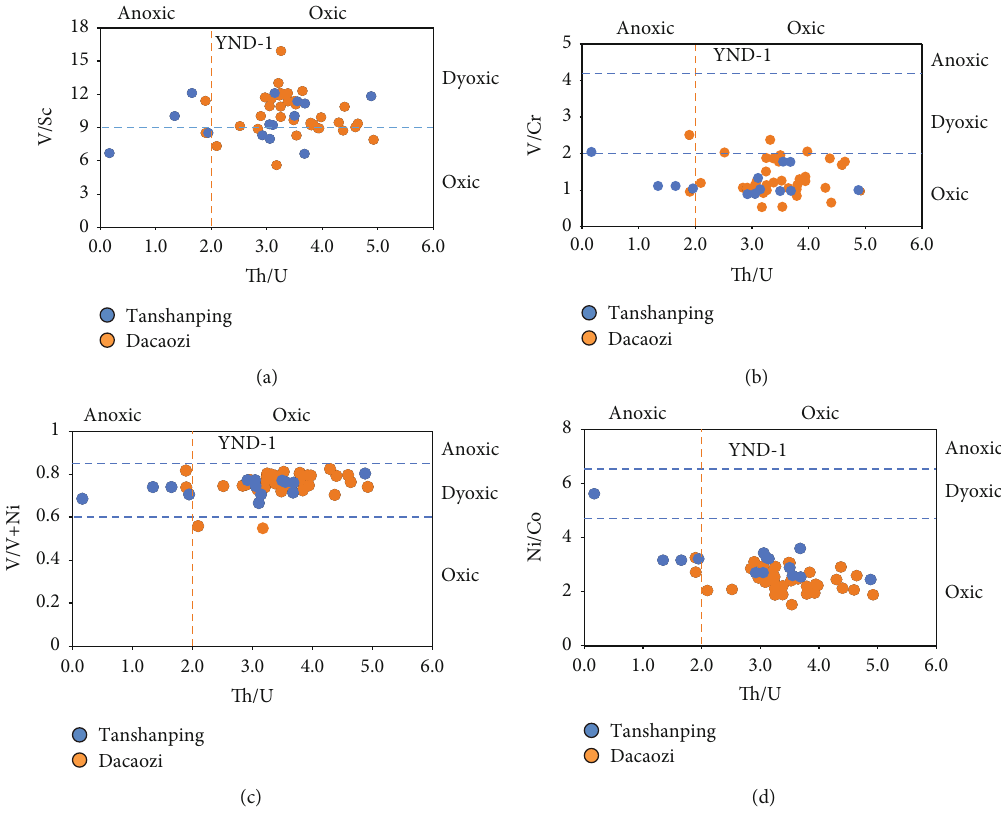
Figure 5: Discrimination of trace elements in di ff erent redox environments of shale in Well